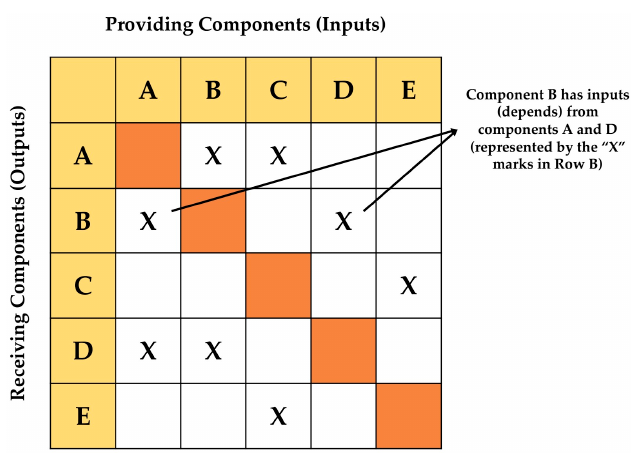
Figure 3. Simplified product/system architecture matrix representing dependencies (based on [39]).